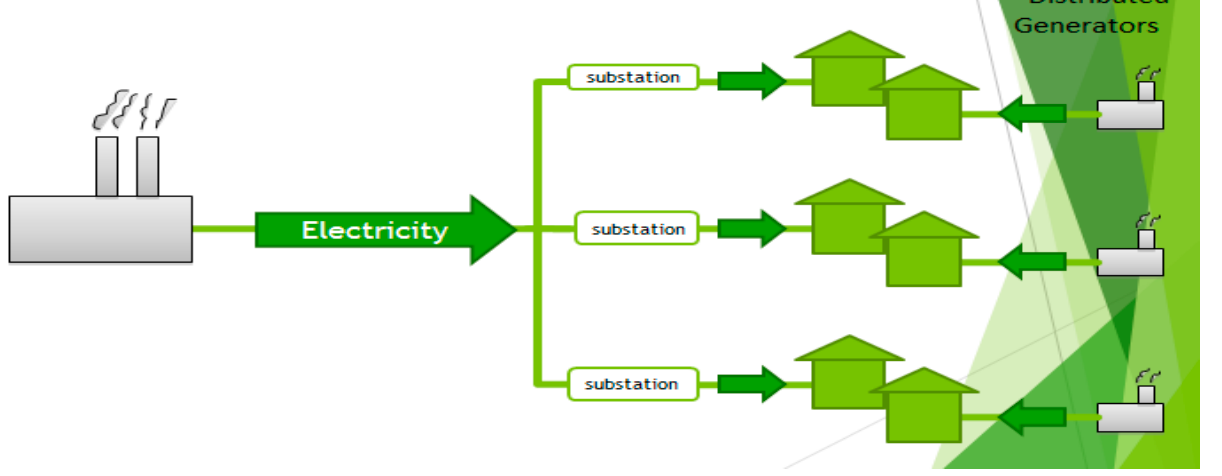
Figure 1. Function of distributed generation units.